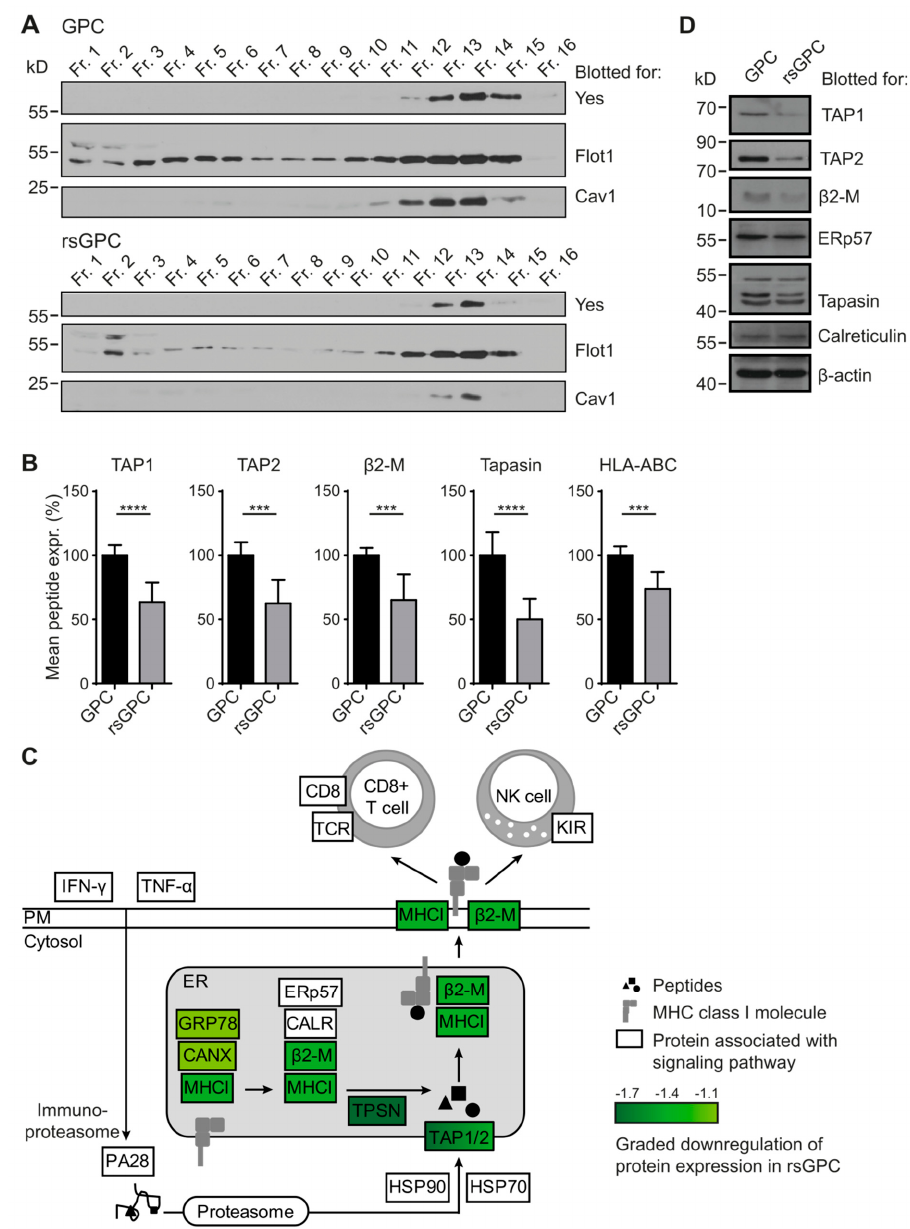
Figure 2. Downregulation of proteins involved in antigen processing and presentation. ( A ) To analyze possible changes in the composition of detergent-resistant membrane (DRM) proteins due to the radio-selection, GPCs and rsGPCs were lysed in 0.5% Brij98 ® lysis buffer and fractionated on a discontinuous sucrose gradient. Fractions 12–15 contained DRM-associated proteins as shown by the expression of lipid raft markers such as Yes, Flot1 or Cav1 and were subsequently processed for mass spectrometric analysis. The results are representative of two independent experiments. ( B ) Analysis of DRM-associated proteins by mass spectrometry revealed that transporters associated with antigen processing (TAP1, TAP2), β 2-Microglobulin ( β 2-M), Tapasin (Tpn), and MHC class I molecules (HLA-ABC) were among the most downregulated proteins in rsGPCs as compared to control GPCs. Values are illustrated as normalized mean ± SD of five technical replicates and two independent experiments. *** p < 0.001; **** p < 0.0001. ( C ) Various proteins associated with antigen processing and presentation were downregulated in rsGPCs as compared to control GPCs. The reduced fold change expression is depicted by a green graded color code. ( D ) Western blot analysis of proteins involved in antigen processing and presentation demonstrated that TAP1, TAP2, β 2-Microglobulin, ERp57, Tapasin but not Calreticulin were downregulated in